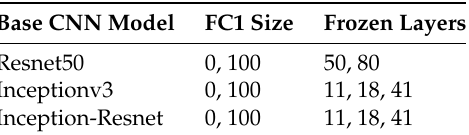
Table 1. CNN architectures and